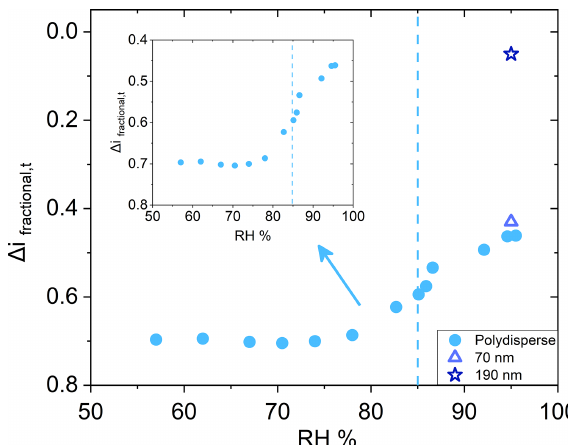
Figure 4. Deliquescence relative humidity curve for polydisperse (initial dry number GMD = 65nm, geometric standard deviation 1.7) sucrose ( • ). Dashed line indicates literature value for deli- quescence. Inset for polydisperse sucrose shown for clarity. Particle bounce for monodisperse 70nm ( (cid:49) ) and 190nm ( ) (both initial dry diameter) AS at 95% chamber RH also